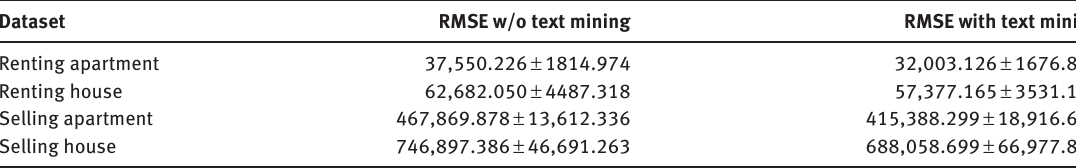
Table 7: RMSE When SVMR Was Used in the First Stage of our Two-Stage Regression Model. Dataset